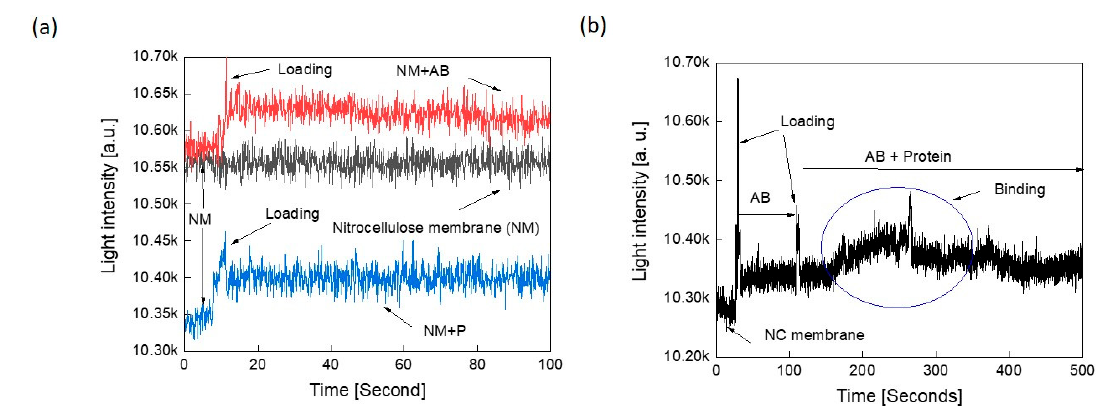
Figure 7. Test of protein–protein interaction measurements on solid support: ( a ) optical responses on nitrocellulose membrane (NM) alone, nitrocellulose membrane and spike protein (NM + P), and nitrocellulose membrane and antibody to spike protein (NM + AB) alone. ( b ) Optical responses to spike protein–antibody binding on the nitrocellulose membrane.